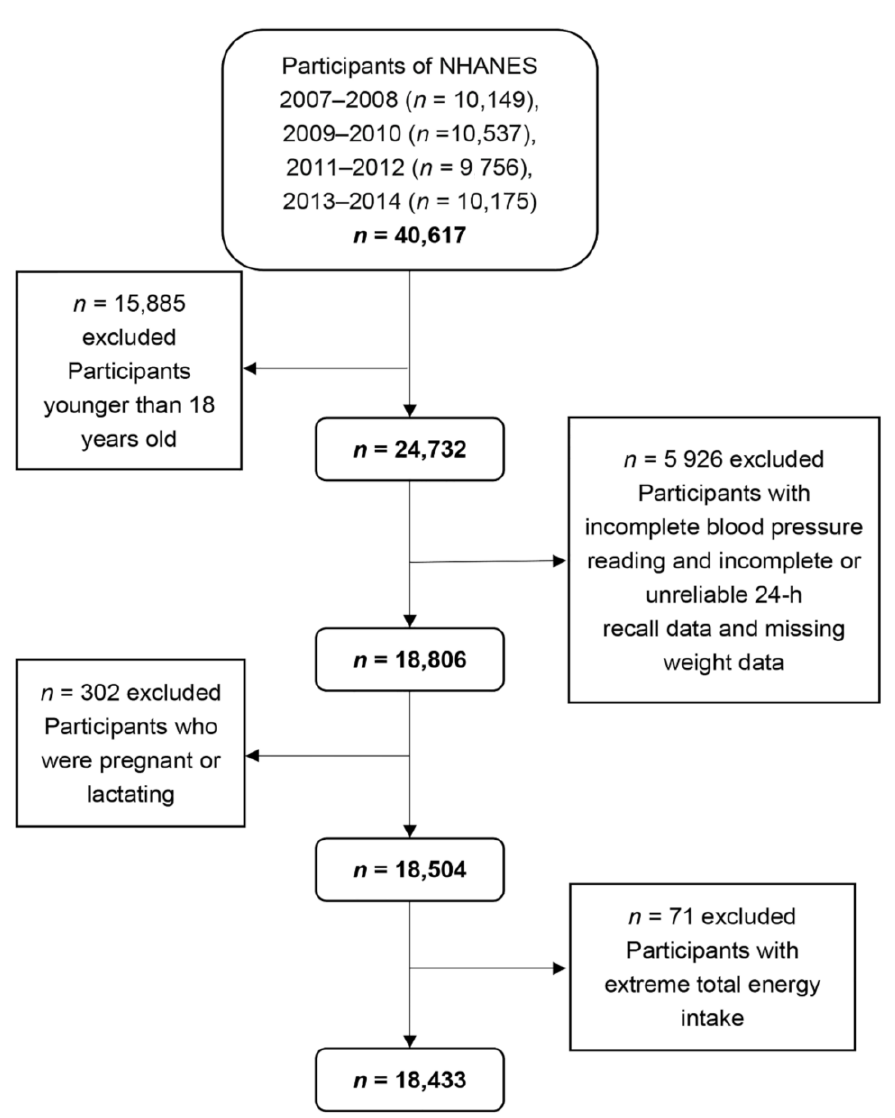
Figure 1. Flow chart of the screening process for the selection of eligible participants. NHANES, National Health and Nutrition Examination Survey.